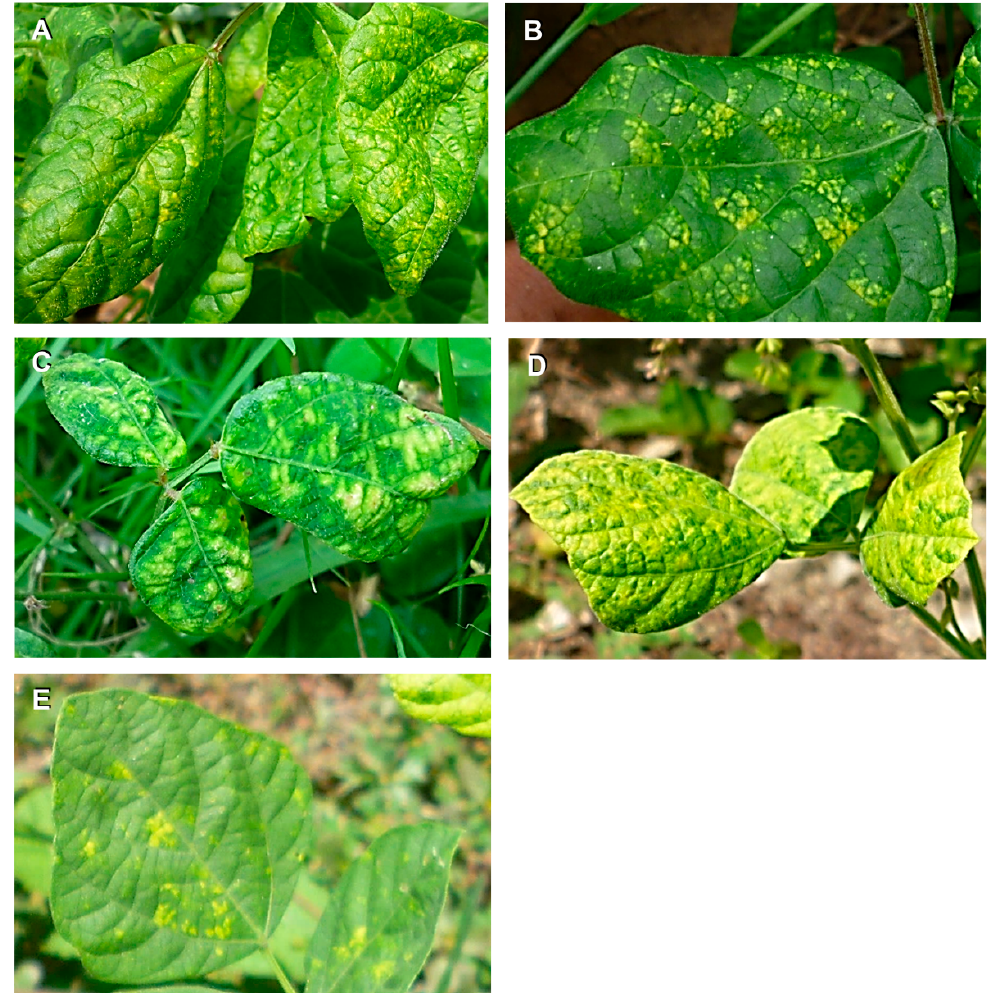
Figure 2. Photographs of some collected leguminous plants showing virus-like symptoms. Samples V3 ( A , Macroptilium bracteatum ), V4 ( B , M. bracteatum ), V7 ( C , Desmodium scorpiurus ), V9 ( D , Rhynchosia minima ), and V11 ( E , R. minima ).